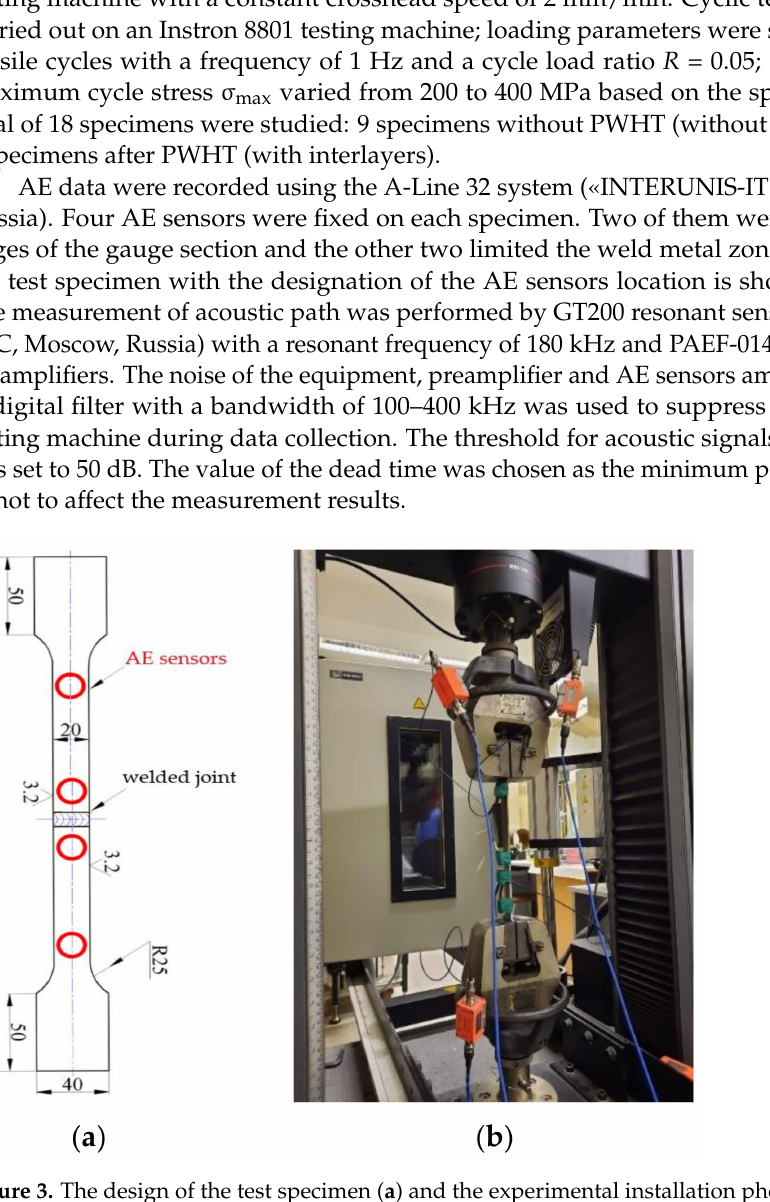
Figure 3. The design of the test specimen ( a ) and the experimental installation photo ( b